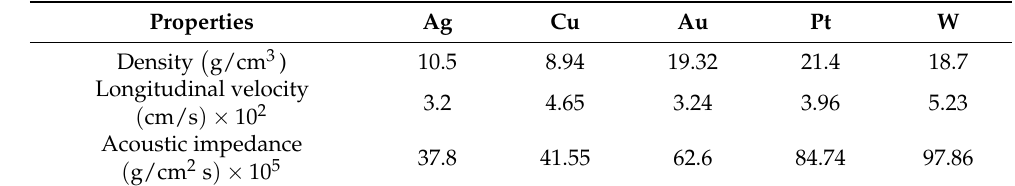
Figure 9. Illustration of simulated electrical responses with different patch metals (i.e., Au, Ag, Cu, Pt, and W). A patch length ( L patch ) of W e /3 and a patch depth ( H patch ) of H 2 / m were used for the simulation. ( a ) Admittance, Y11 (dB), and ( b ) conductance, G(dB). Table 3. Properties of metals considered for the patch design.